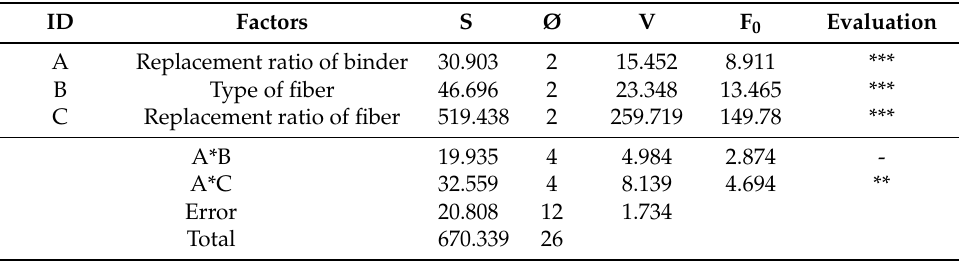
Table 11. Variance analysis for the compressive strength of the extrusion